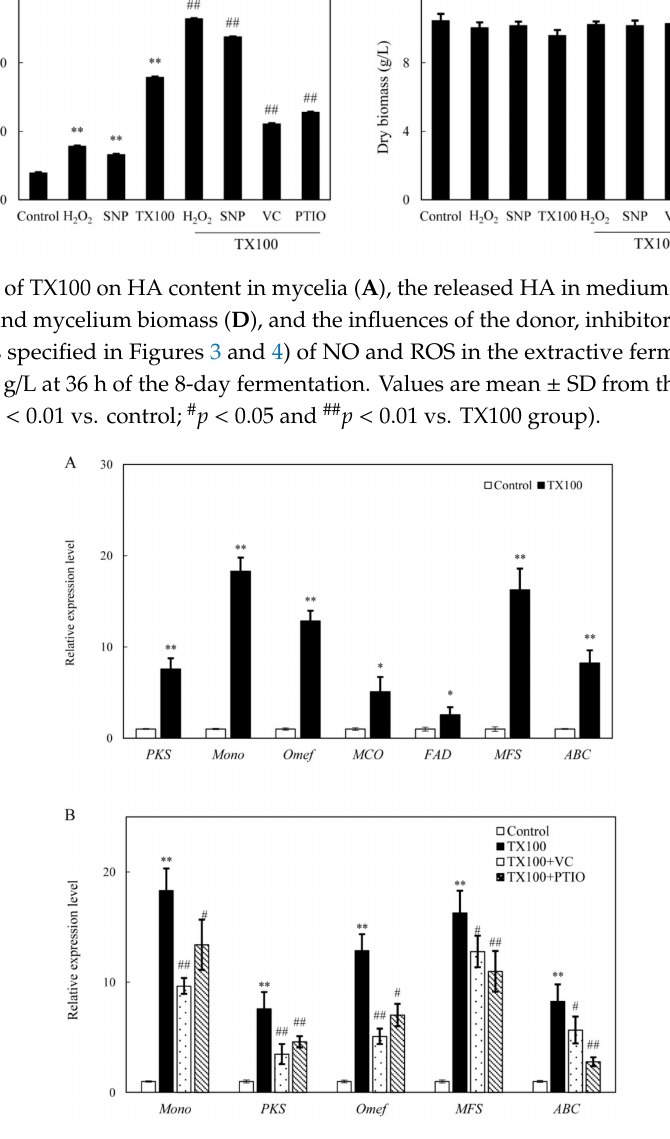
Figure 7. E ff ect of TX100 on the gene expressions for Shiraia HA biosynthesis ( A ) and the influences of the donor, inhibitors and scavengers (the dosage as specified in Figures 3 and 4) of NO and ROS on the gene expressions in the mycelium ( B ). TX100 was added at 25 g / L on day 1.5 for 24 h of TX100 treatment. Values are mean ± SD from three independent experiments ( ** p < 0.01 vs. control; # p < 0.05 and ## p < 0.01 vs. TX100